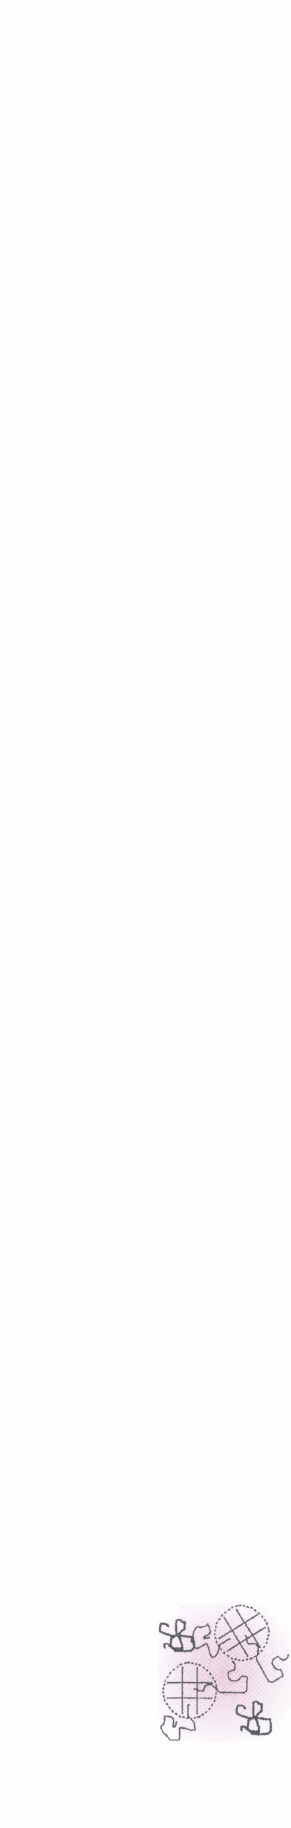
Table 1: The experimental protocol - mixture compositions and temperatures used: A: Agar W: Water Z:Sugar(sucrose) W+Z: Sugar